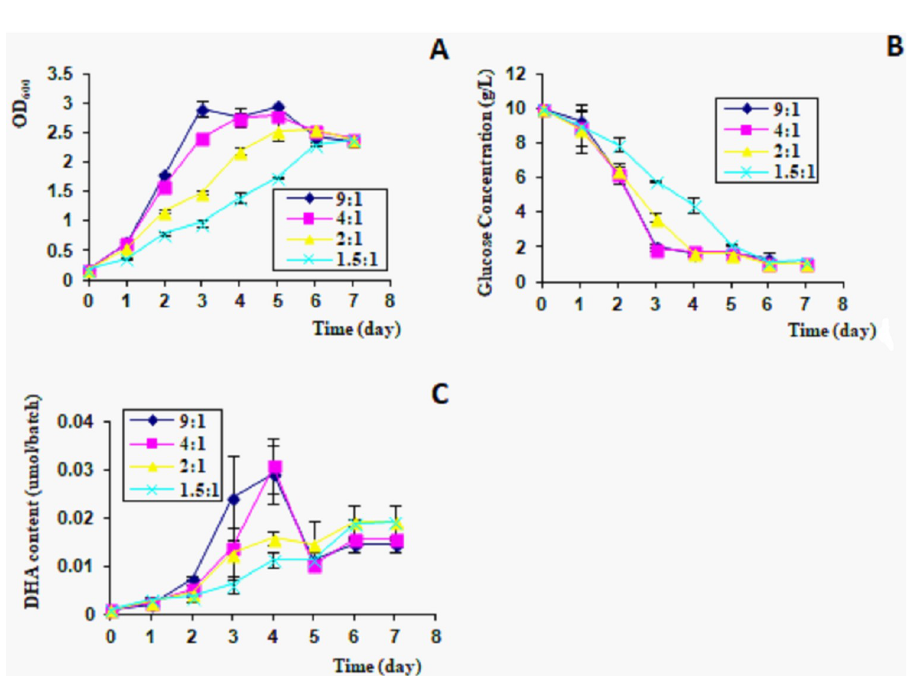
Fig 4. Growth rate and DHA production at different air/culture ratios. 5 ml (9:1), 10 ml (4:1), 15 ml (2:1), and 20 ml (1.5:1) of medium in 50 ml tubes. A, OD 600 ; B, glucose consumption; C, DHA content in culture, 300 μ l/batch.